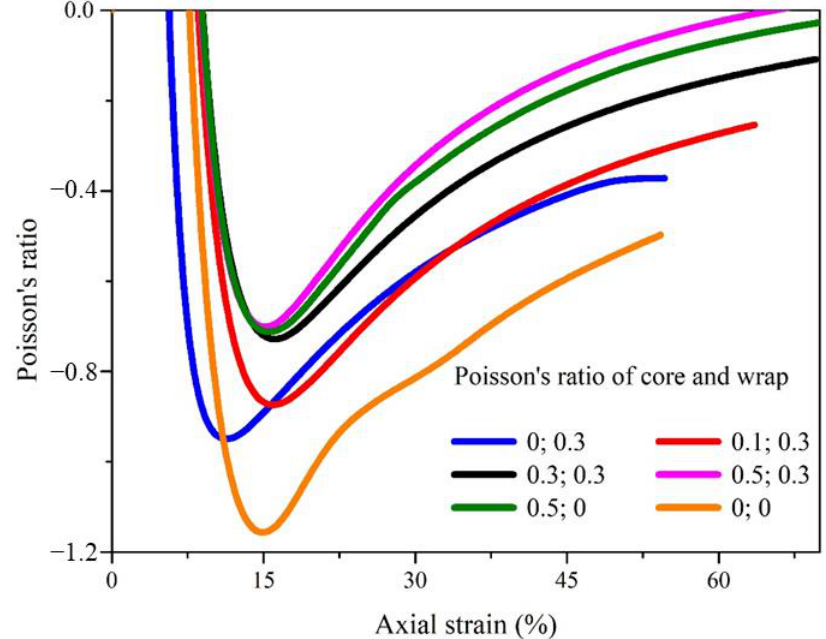
Figure 6. The effect of filament Poisson’s ratio on the auxetic property of complex yarns. Table 1. Auxetic property of complex yarns with filaments with different Poisson’s ratios. Poisson’s Ratio